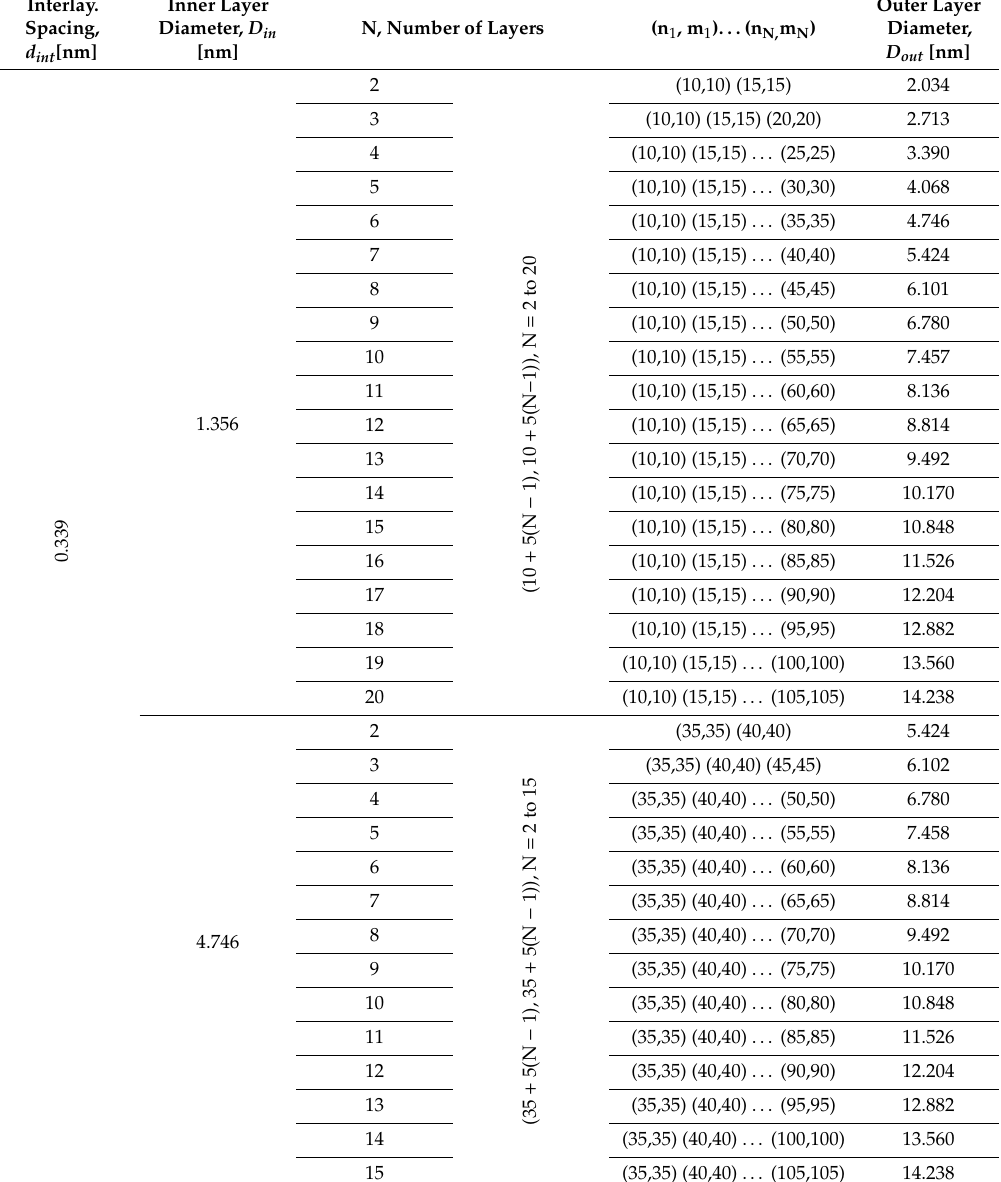
Table2. Geometricalcharacteristicsofarmchairmultiwalledcarbonnanotubes(MWCNTs), understudy. Interlay.